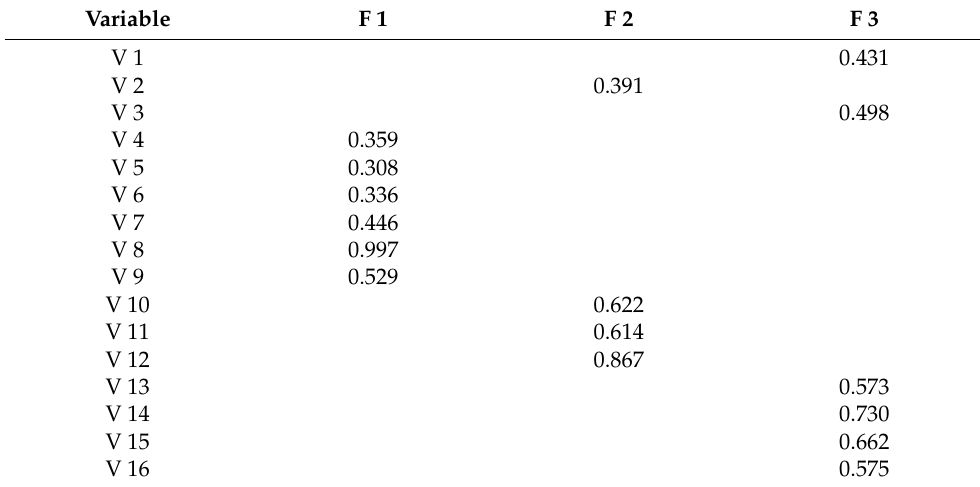
Table 1. Matrix of rotated factors.